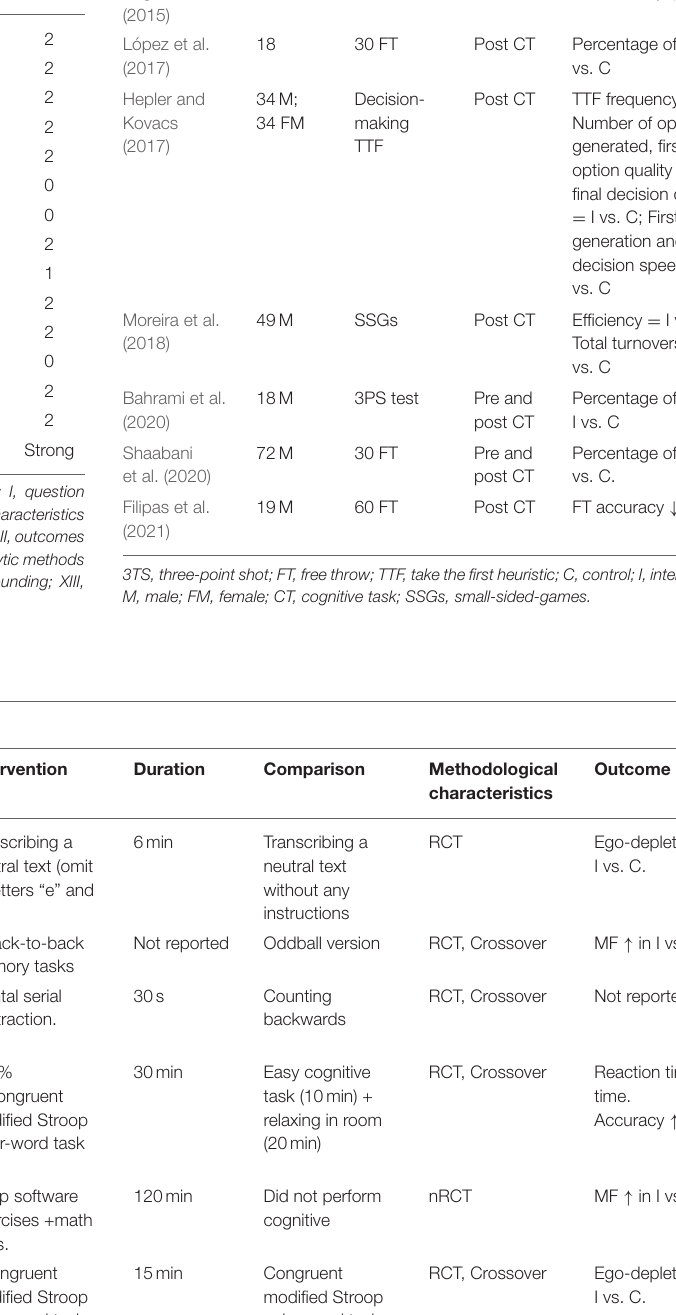
TABLE 2 | Quality assessment “Qualsyst”. Items Englert et al.